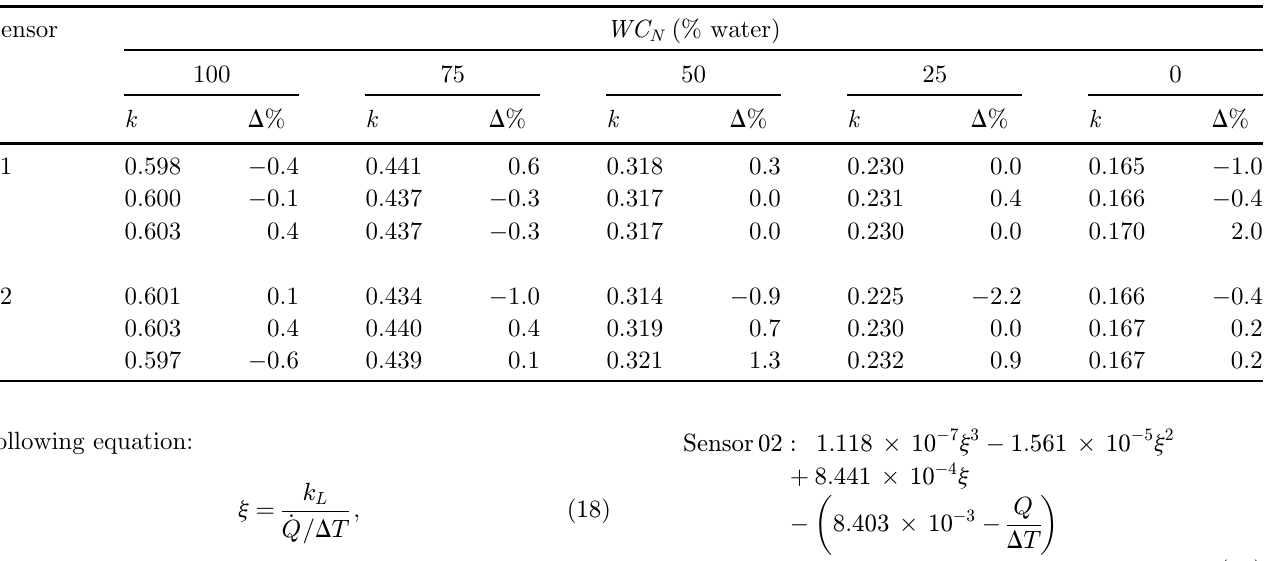
Table 4. Experimental ratios WC (% water) N